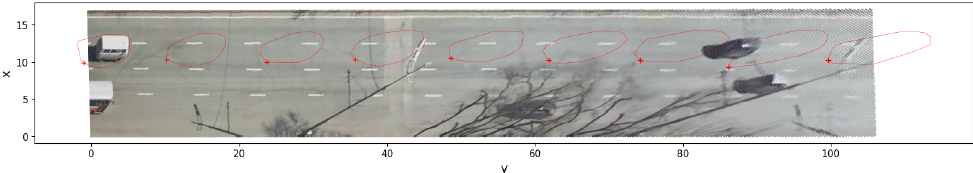
Figure 8. Every twentieth contour in the vehicle’s trajectory mapped on the Q π with the se- lected